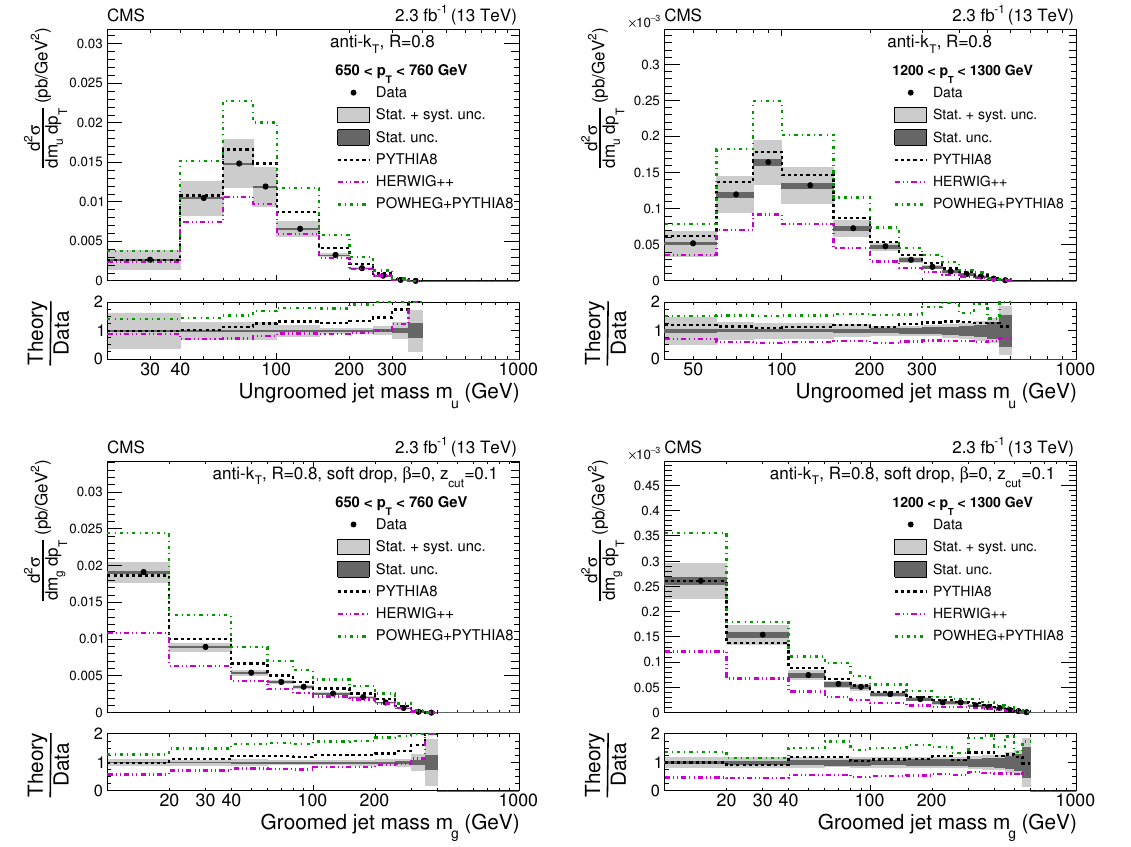
Figure 6 . Absolute cross section for ungroomed (top) and groomed (bottom) jets for two p T bins. The data are shown by the black points, with dark grey bands for the statistical uncertainty (Stat. unc.) and with light grey bands for the total uncertainty (Stat. + sys. unc., added in quadrature). The predictions from pythia 8, herwig++ , and powheg + pythia are shown with dashed black, dash-dot-dotted magenta, and dash-dotted green histograms, respectively, with no uncertainties shown. The MC simulations are normalized to the data over the entire p T